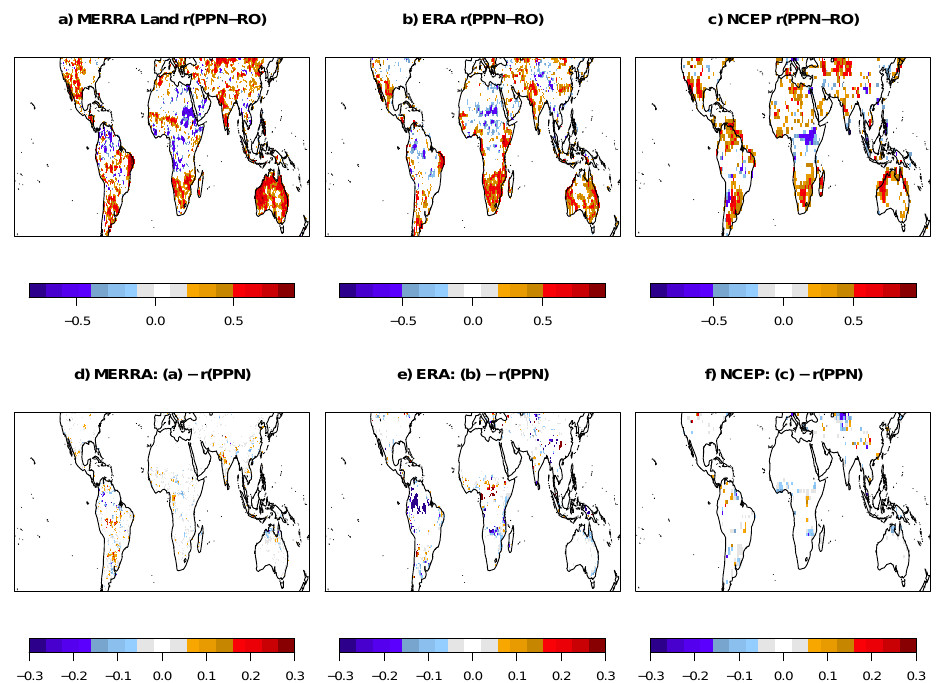
Figure 10. Spatial distributions of correlations between NDVI time series and potential NPP time series calculated from annual evapotran- spiration amounts for 1982–2010 (2000 excluded). Annual evapotranspiration was estimated as precipitation–runoff. (a) Correlations for MERRA Land reanalysis; (b) correlations for ERA Interim reanalysis; (c) correlations for NCEP/NCAR surface Gaussian